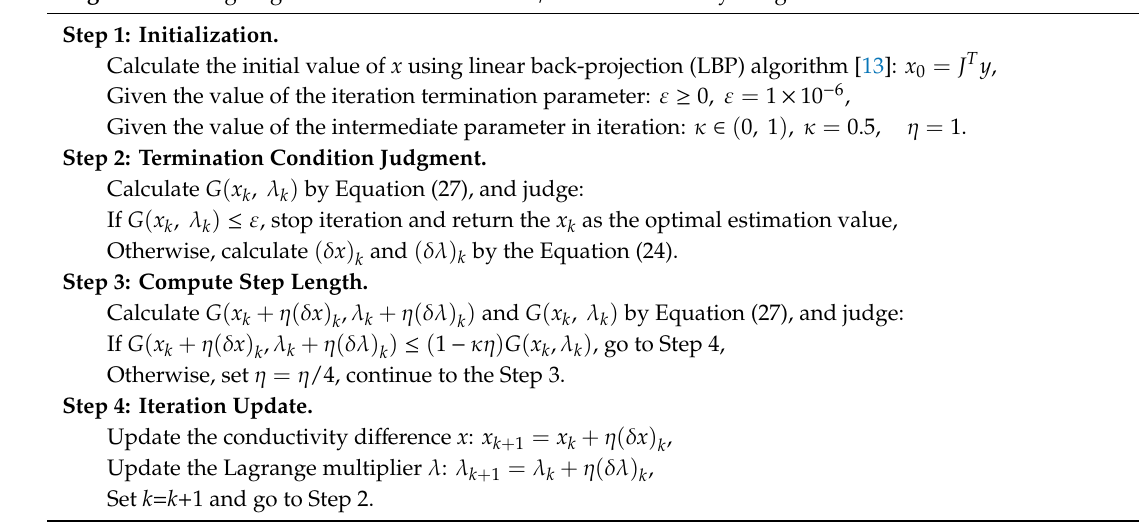
Algorithm 1: Lagrange-Newton Method for EIT / UT Dual-Modality Image